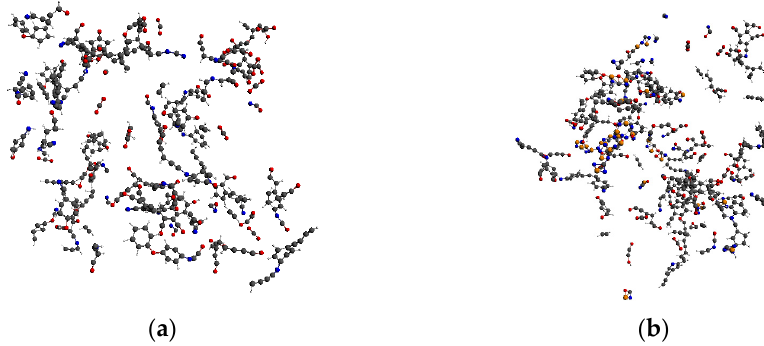
Figure 5. Pyrolysis results at 3000 K. ( a ) PI neat; ( b ) PI/BNNS.